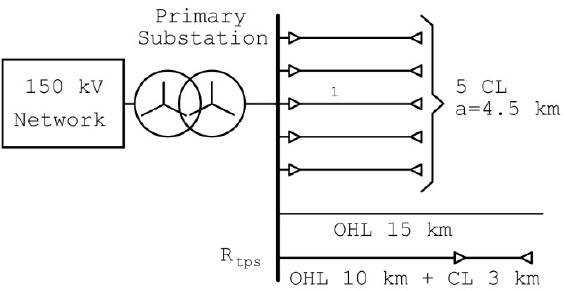
Figure 7. Single line diagram of the studied 20 kV–50 Hz distribution network.